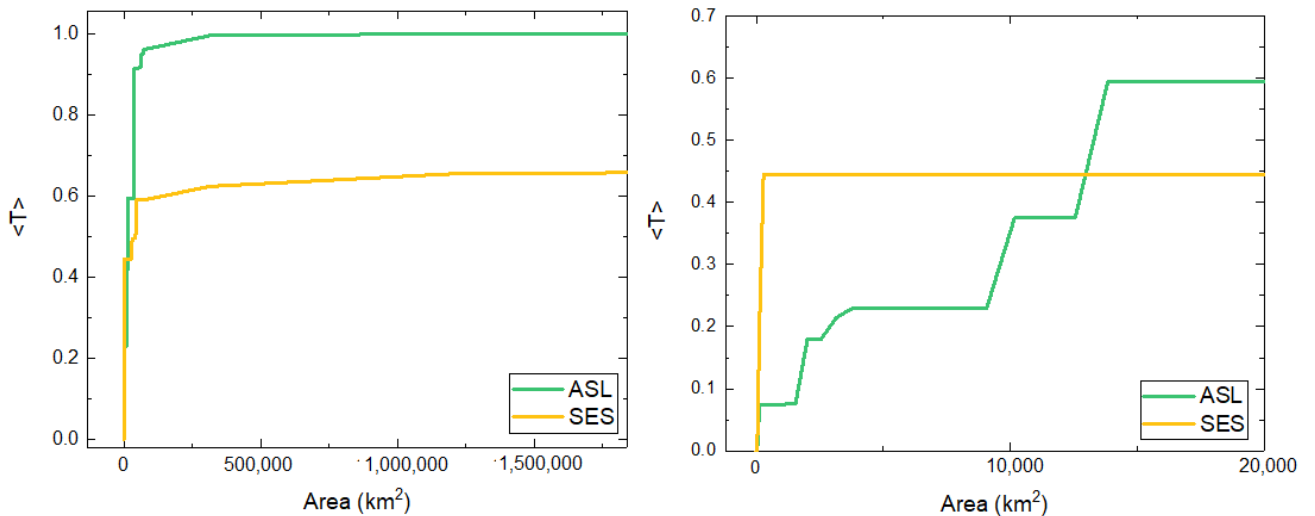
Figure 9. ( Left ) Average number of transmitted packages per unit of time as a function of the covered area for the case of random distribution of receiver stations for trajectories of SES and ASL. ( Right ) Same figure as the left panel, for total reception areas smaller than 20,000 km 2 . Since we associate the behavior of the SES with a smaller value of the parameter a than the one for the ASL, the colors of the curves are analog to the curves for small and great a shown in Figure 2.